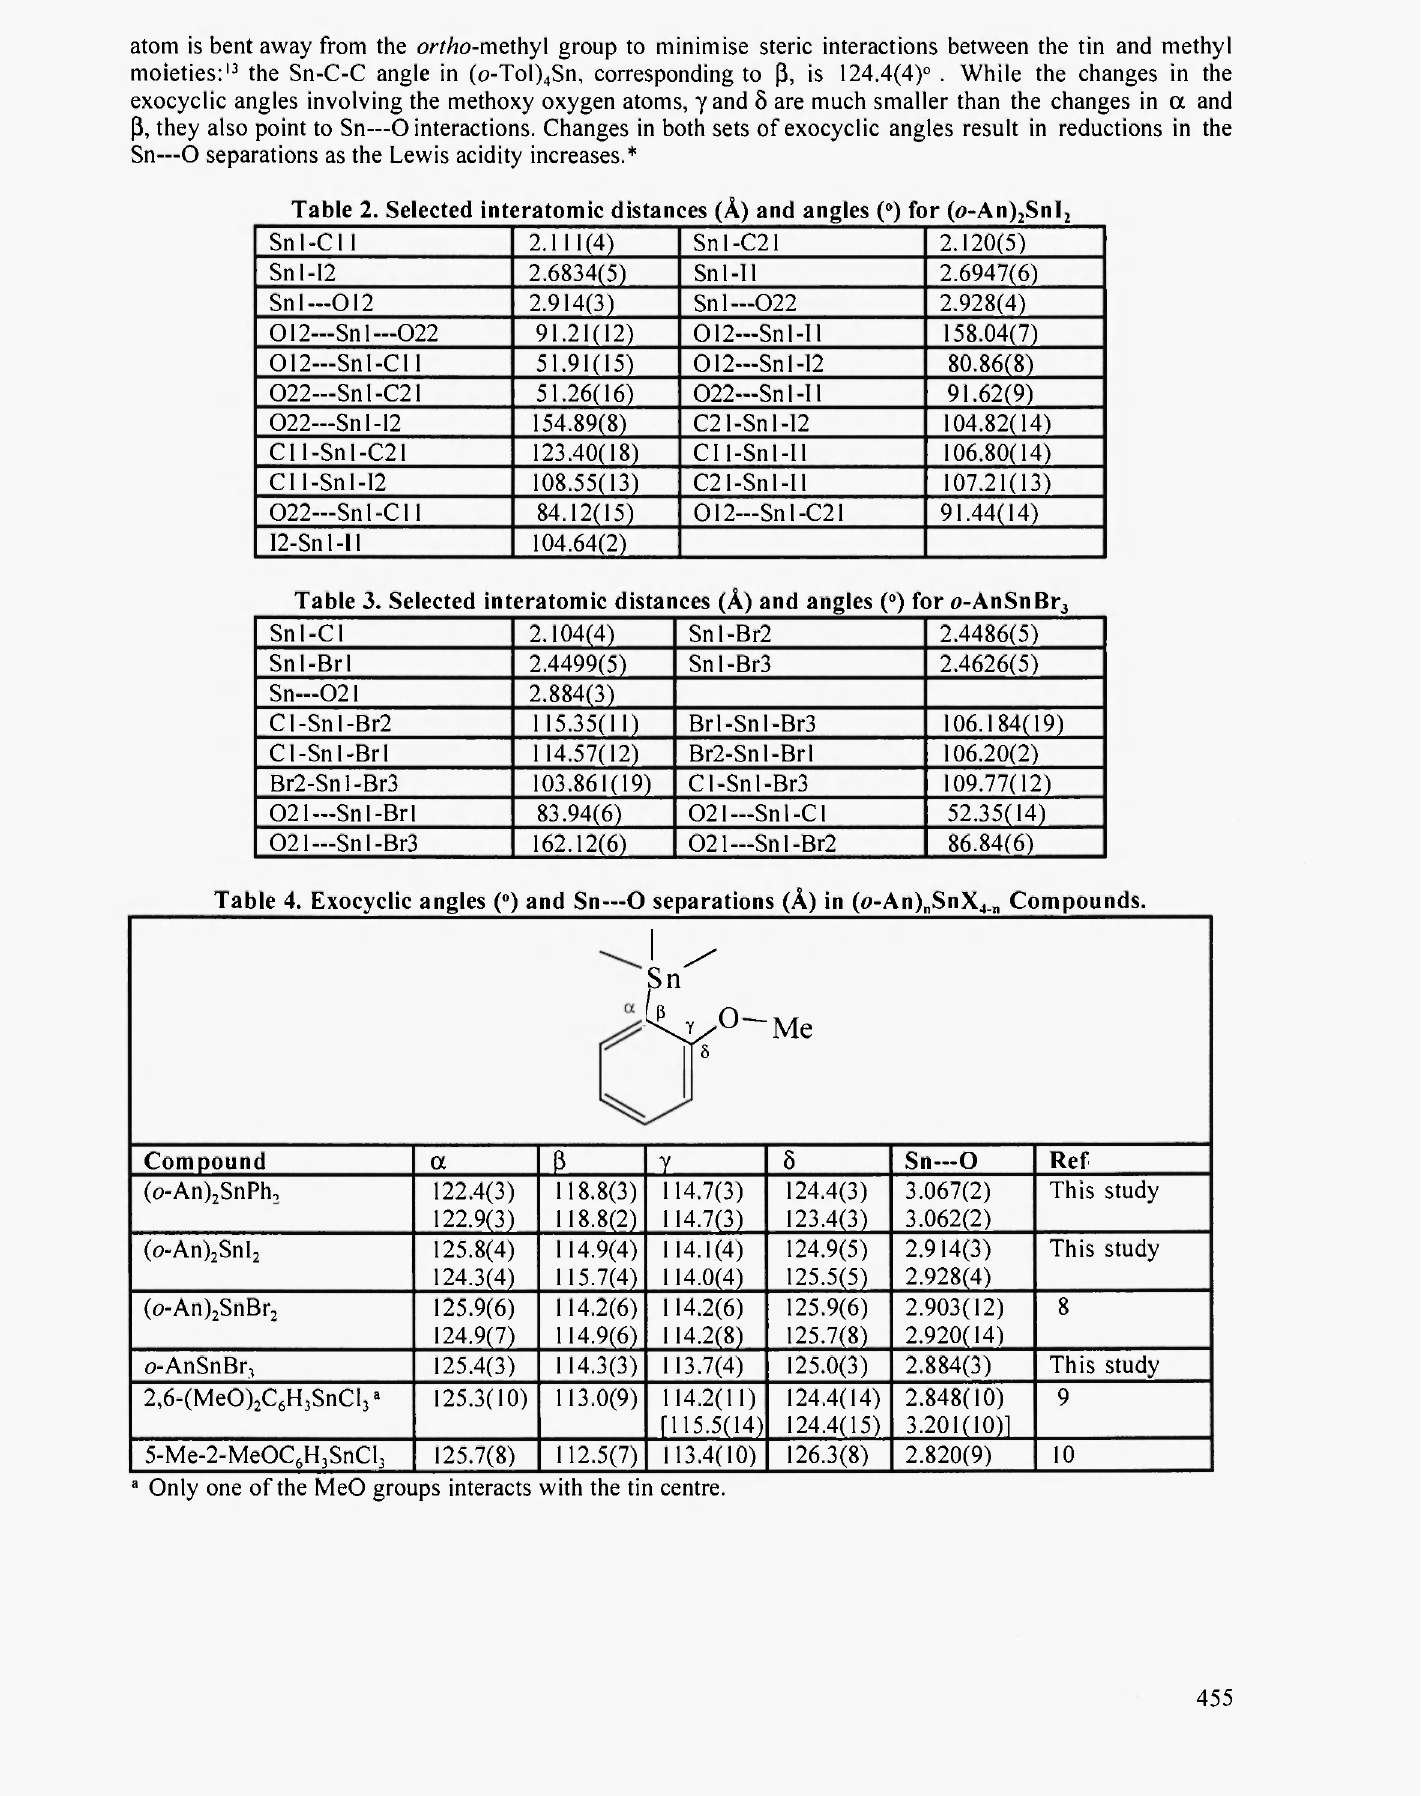
Table 2. Selected interatomic distances (A) and angles (") for (o-An) 2 SnI 2